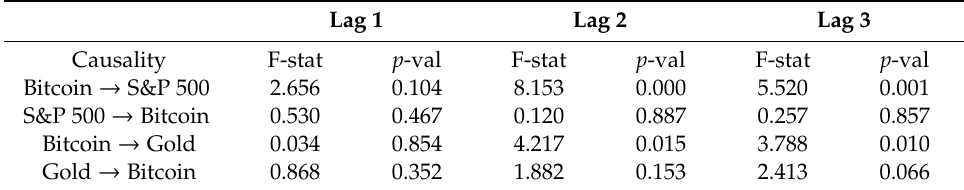
Table 3. The result of linear Granger causality with lag of 1, 2, and 3. There is no Granger causality between the log-returns of Bitcoin (LBTC) and S&P 500 (LSP) and Bitcoin (LBTC) and Gold (LGD), respectively. Lag 1 Lag